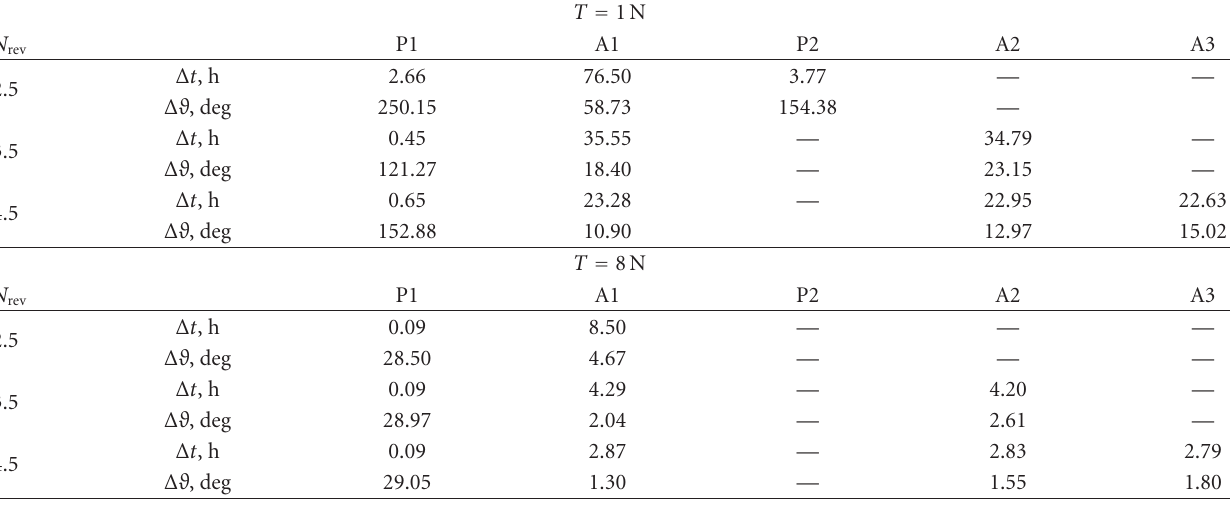
Table 2: Time length and angular length of burn arcs (J2 only).